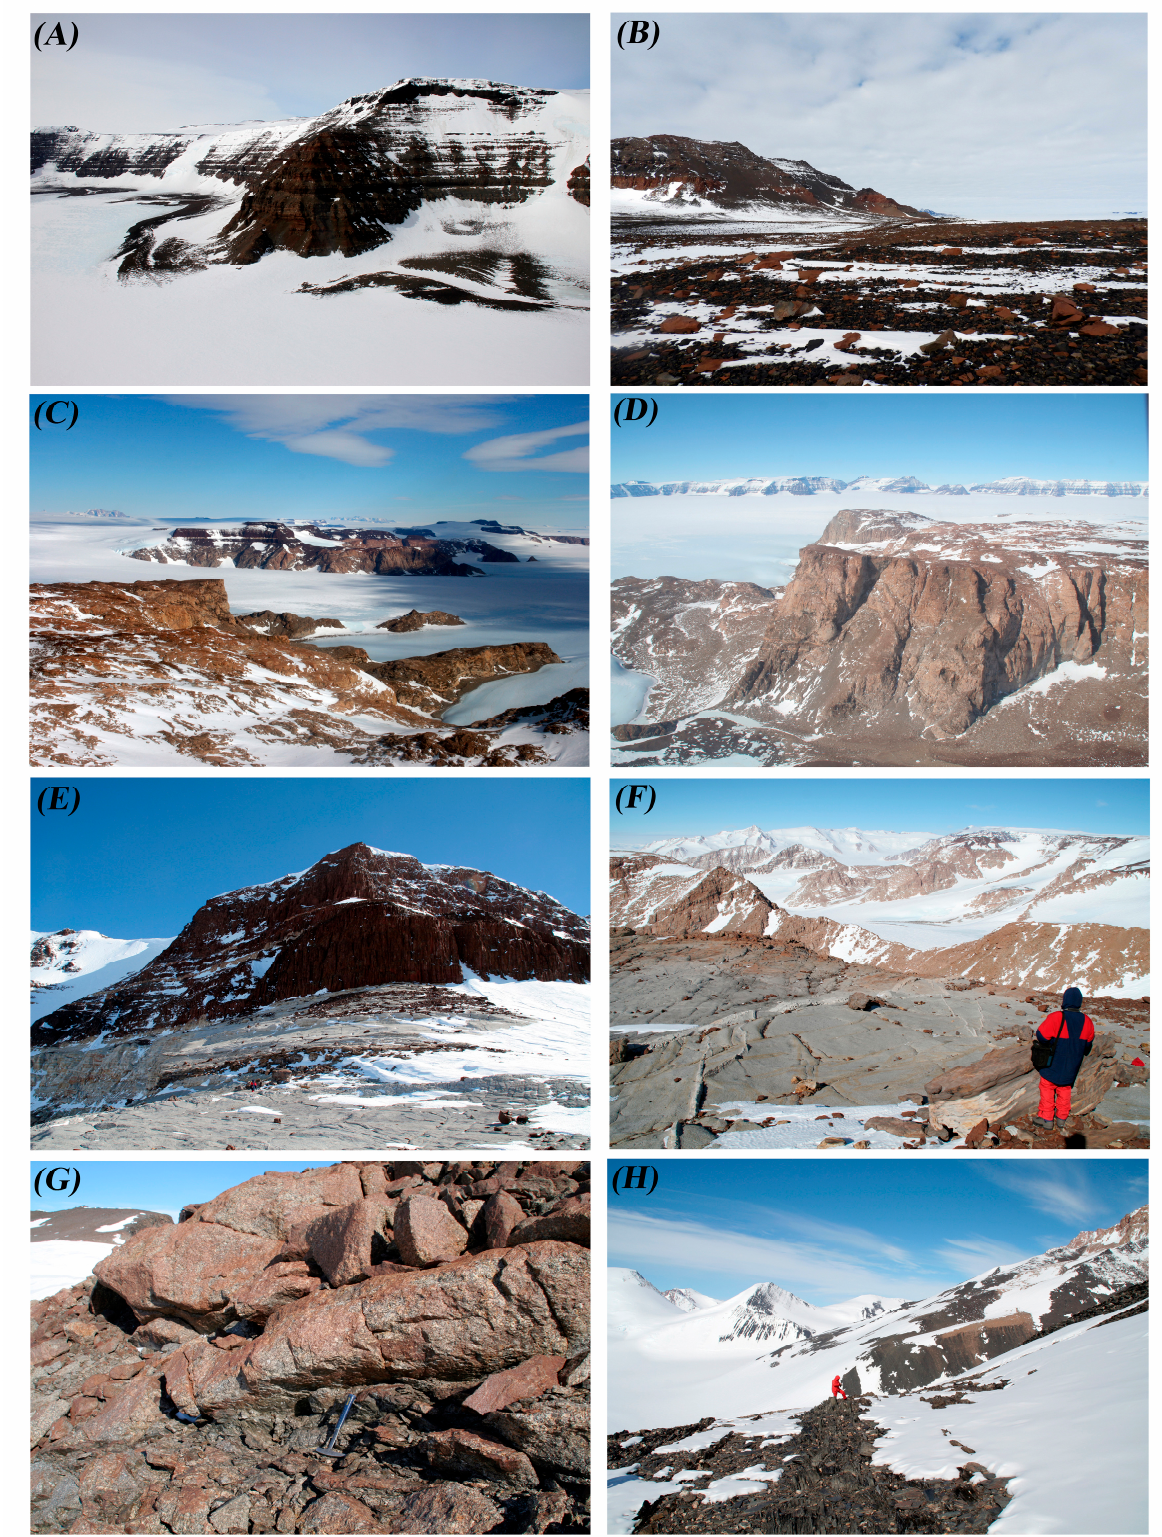
FIG 13 Figure 13. Field photographs of the bedrock lithologies. ( A ) Helicopter view of Kirkpatrick Basalts (series of lava flows) in the western flank of Tobin Mesa, southern Mesa Range; ( B ) Regional view of glacial deposits and debris composed of Kirkpatrick Basalts and Ferrar Dolerite associated with zeolite-bearing volcanoclastic and sandstone in southern Mesa Range; ( C ) Regional view of the exposures of sheeted leucogranite of the Granite Harbour Intrusives and schists of the Wilson Metamorphic Complex and sandstone of the Beacon Supergroup, Lichen Hills, Mesa Range area; ( D ) Helicopter view of flat hills with steep escarpments of Granite Harbour Intrusives and schists of the Wilson Metamorphic